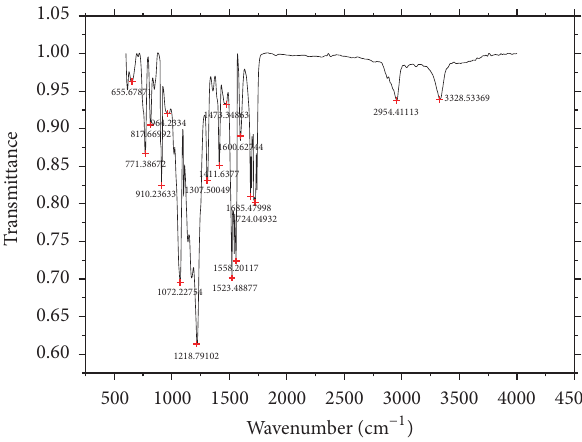
Figure 8: ATR-FTIR spectrum of immobilized PU/TiO 2 .